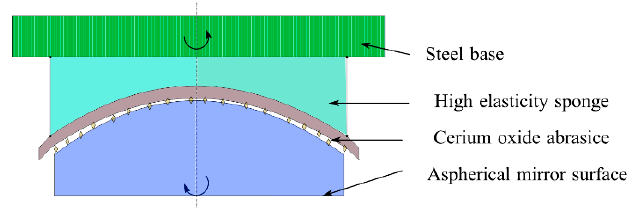
Figure 21. Polishing diagram.